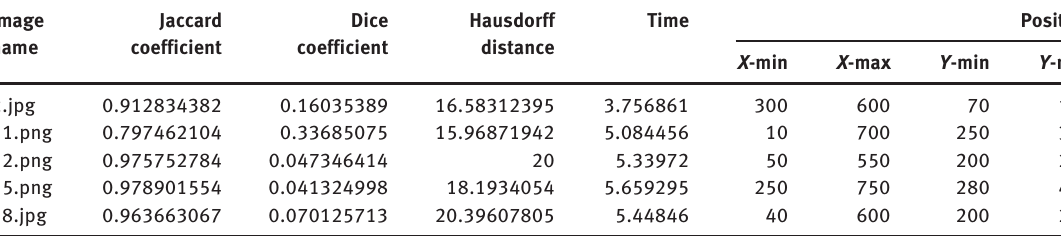
Table 1: Performance Analysis Using the Proposed OFA-based ACM.